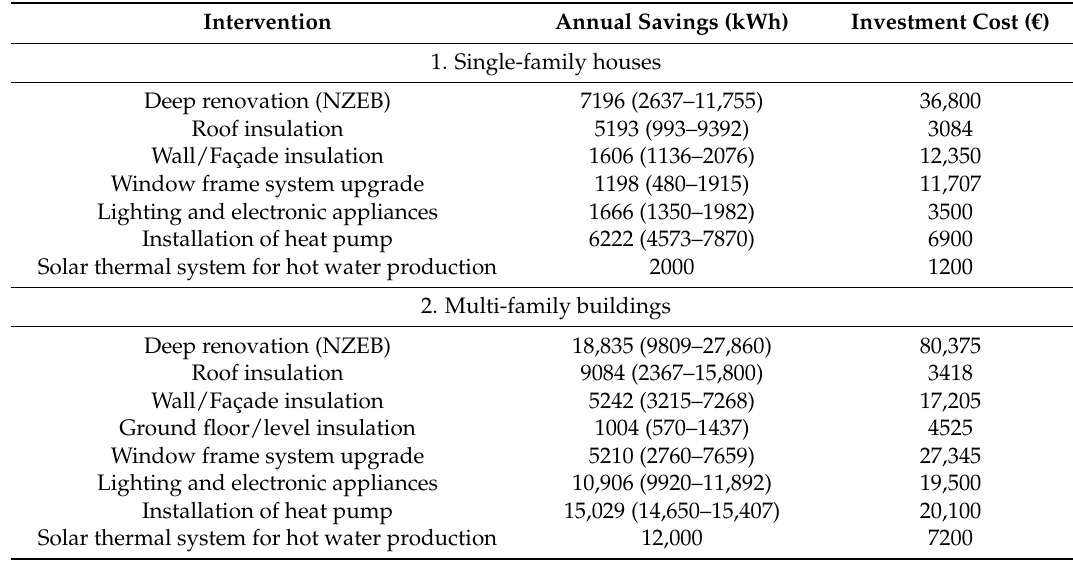
Table 5. Estimated annual energy savings and mean investment cost of energy efficiency interventions in residential buildings of